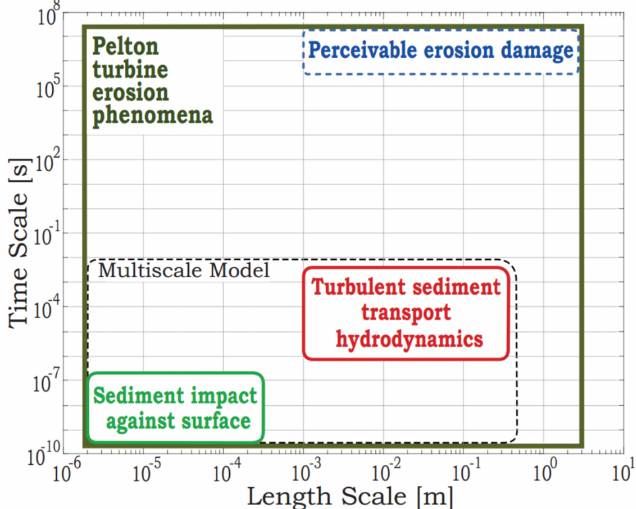
Figure 1. Time and length scales involved in the erosion process of a Pelton turbine [17]. The time bounds represent the simulation time step required and its overall duration, whereas the length bounds represent the discretization size necessary for convergence and the overall domain